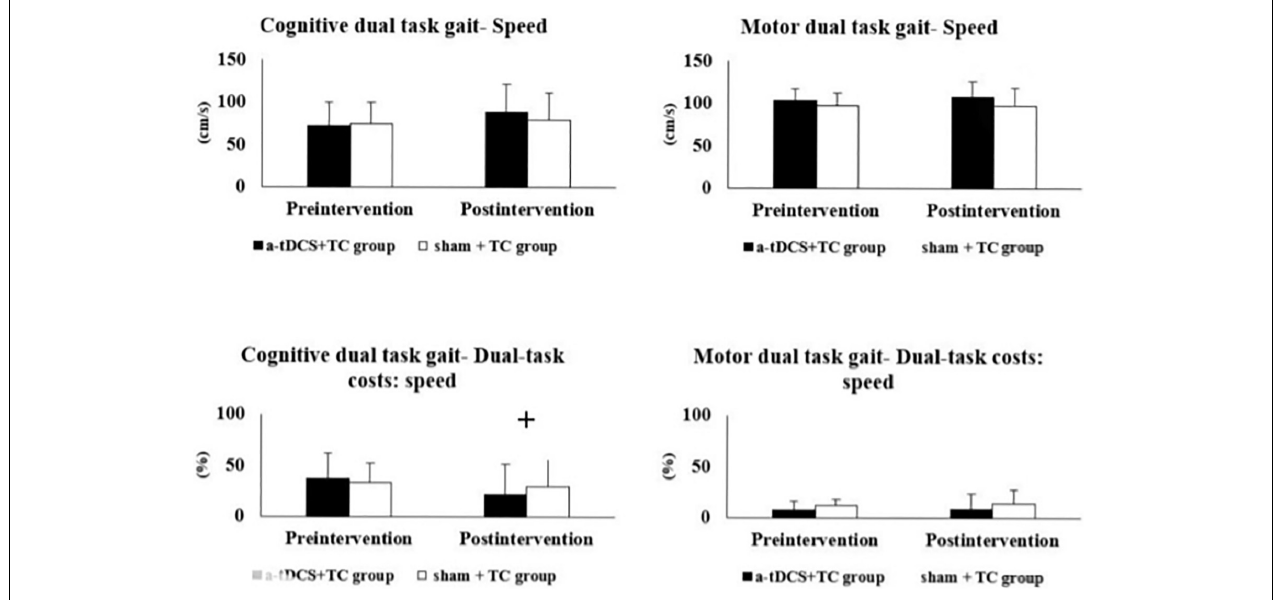
FIGURE 2 | Comparisons of single- and dual-task gait performance in the a-tDCS+TC group and sham+TC group. + p < 0.05 significant interactions between group and